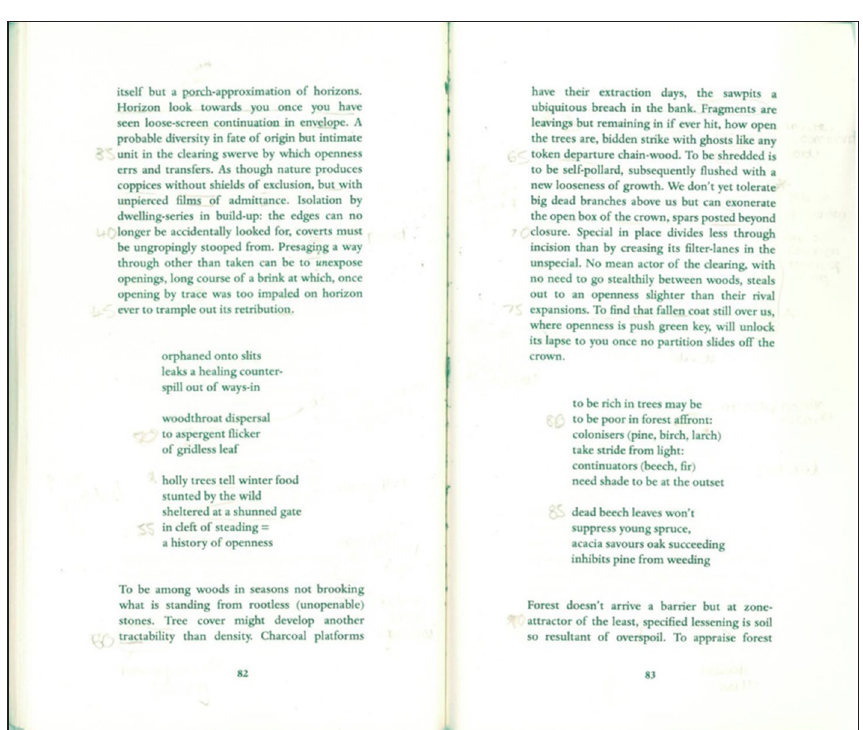
Figure 1: Peter Larkin, from Leaves of Field, Exeter: Shearsman Books, 2006.